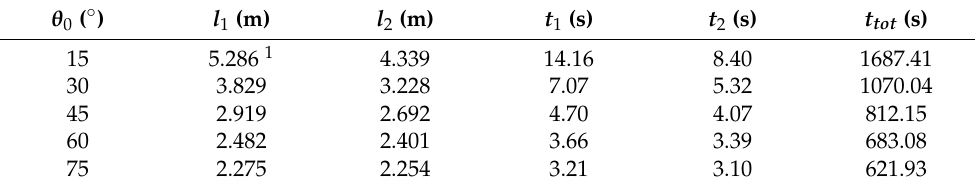
Table 1. For each initial inclination angle examined, trajectory lengths 𝑙 (cid:2869) and 𝑙 (cid:2870) of the buoyant jet at the first and the last simulation cycle, along with the corresponding total times 𝑡 (cid:2869) and 𝑡 (cid:2870) , as well as the total duration 𝒕 𝒕𝒐𝒕 of all cycles, for temperature stabilisation of the room air at 27 °C.